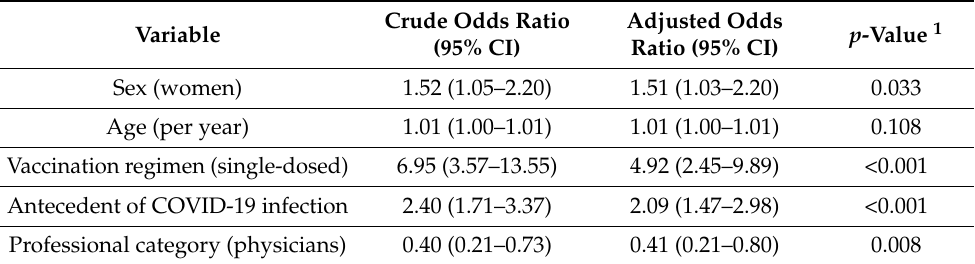
Table 3. Crude and adjusted odds ratio for the report of adverse reactions after COVID-19 vaccination in hospital workers.